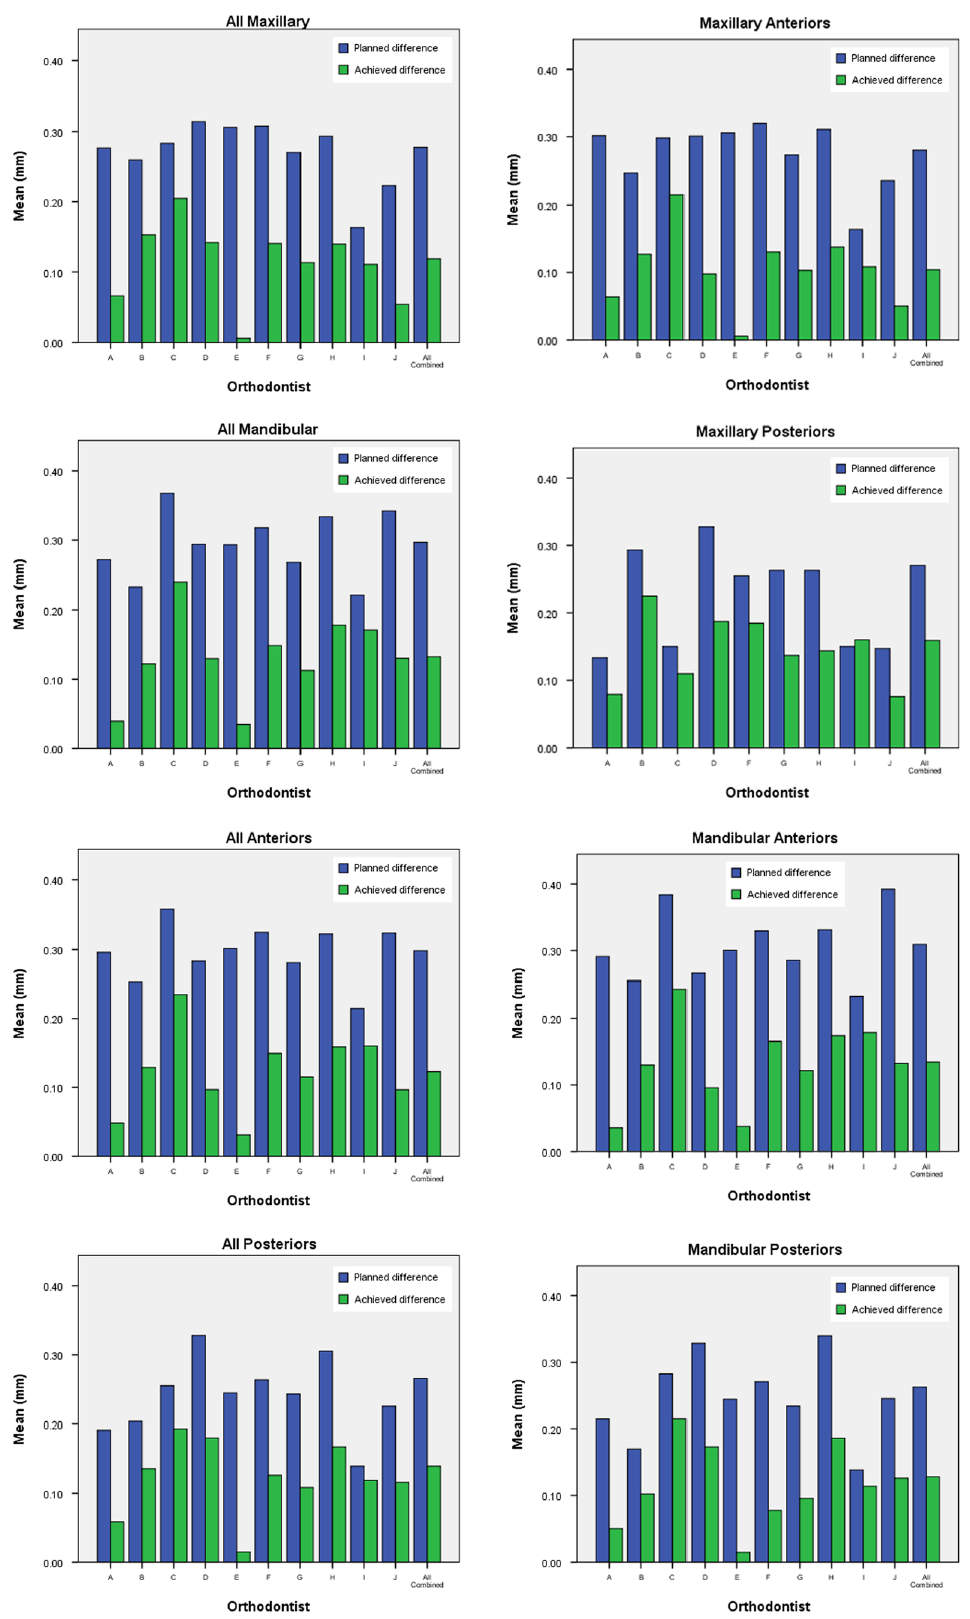
Figure 6. Sub-groups by orthodontist and all